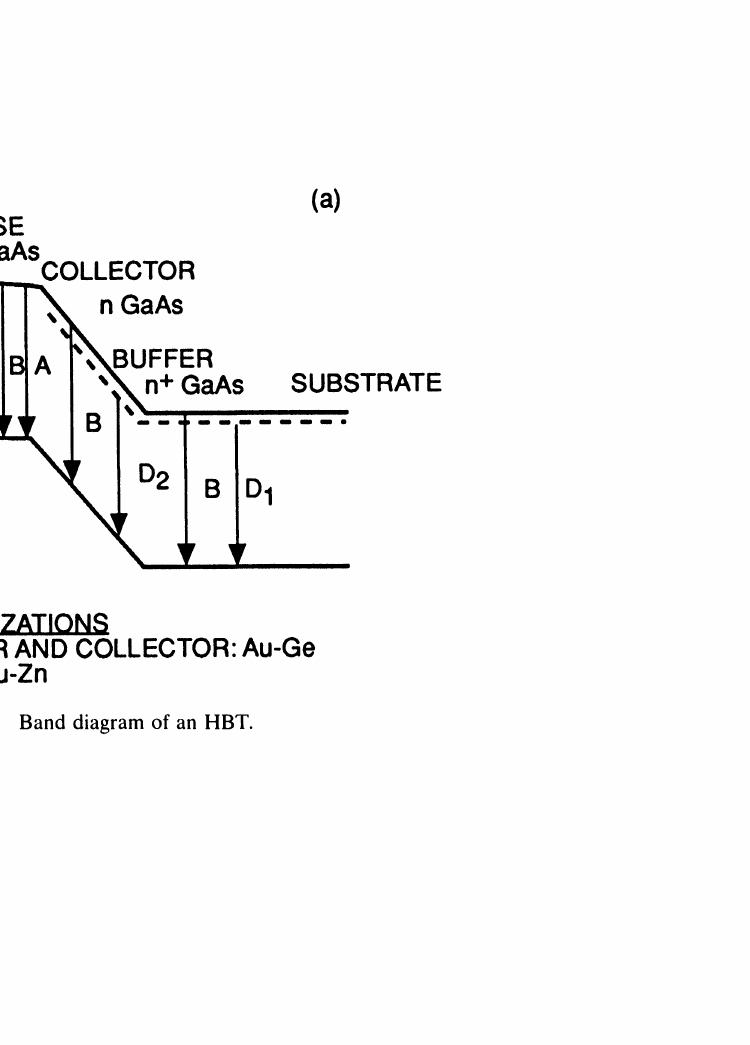
FIGURE 5 Band diagram of an